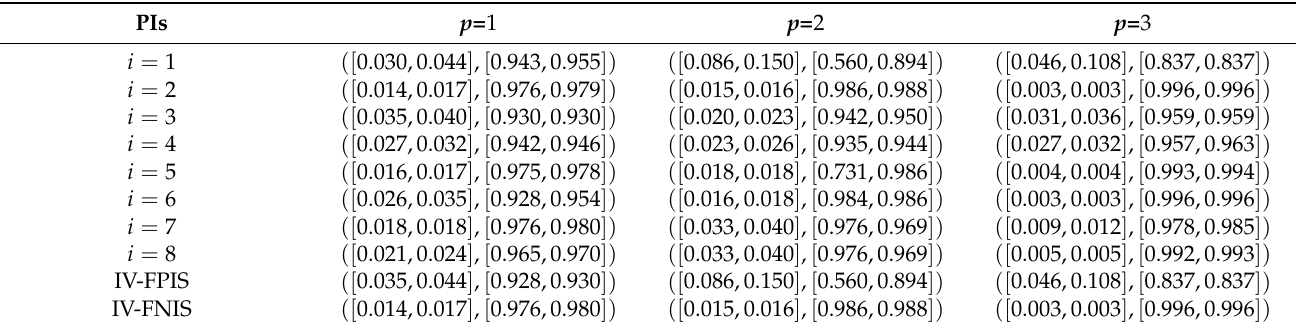
Table 9. The weighted normalized fuzzy decision matrix.